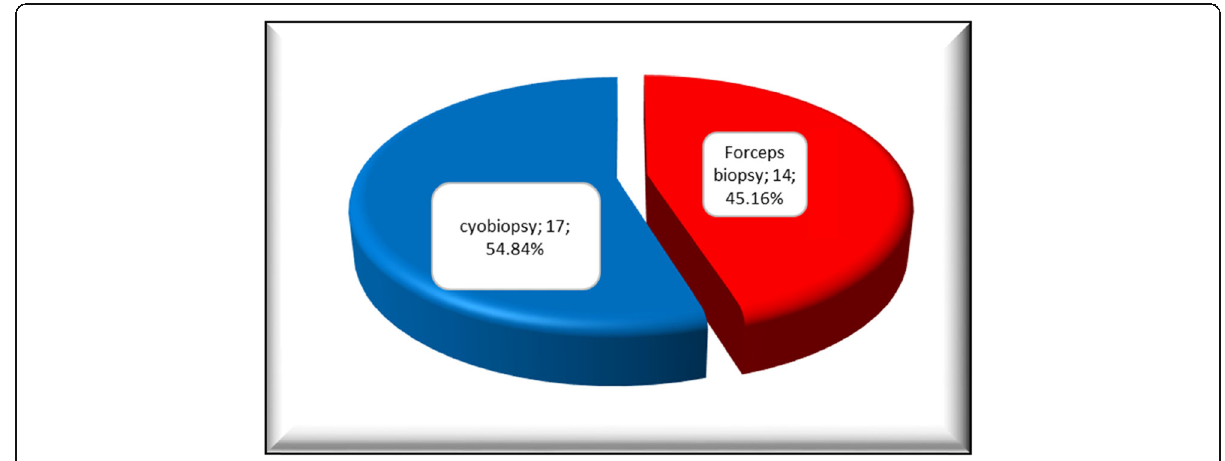
Fig. 1 Biopsy techniques in the bronchoscopic